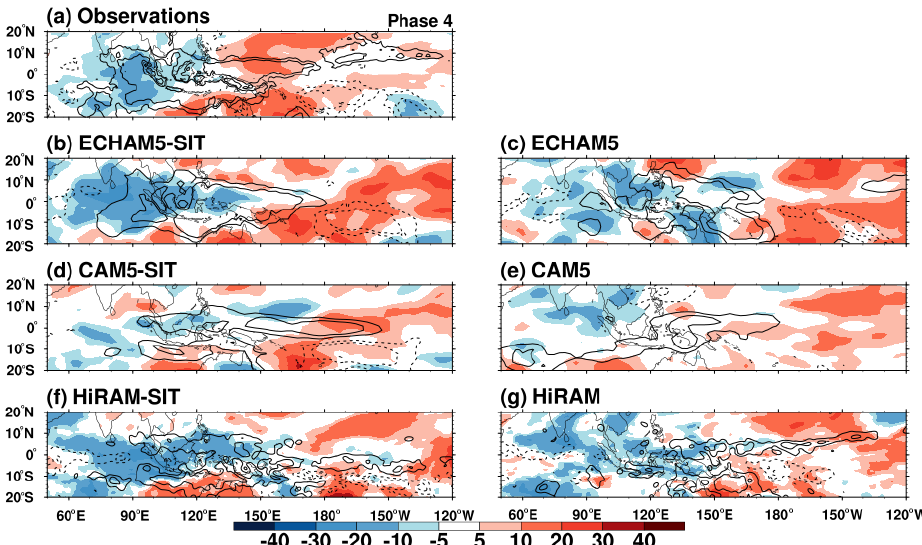
Figure 10. Phase 4 of the column-integrated MSE tendency (shading; Jkg − 1 s − 1 ) and precipitation (contours; mmd − 1 ) based on (a) obser- vations, (b) ECHAM5-SIT, (c) ECHAM5, (d) CAM5-SIT, (e) CAM5, (g) HiRAM-SIT, and (f) HiRAM. The nine-point local smoothing is applied here to the intraseasonal precipitation variance of HiRAM (contours